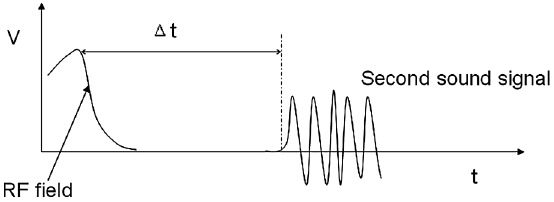
FIG. 1. Measurement of quench point by second sound.